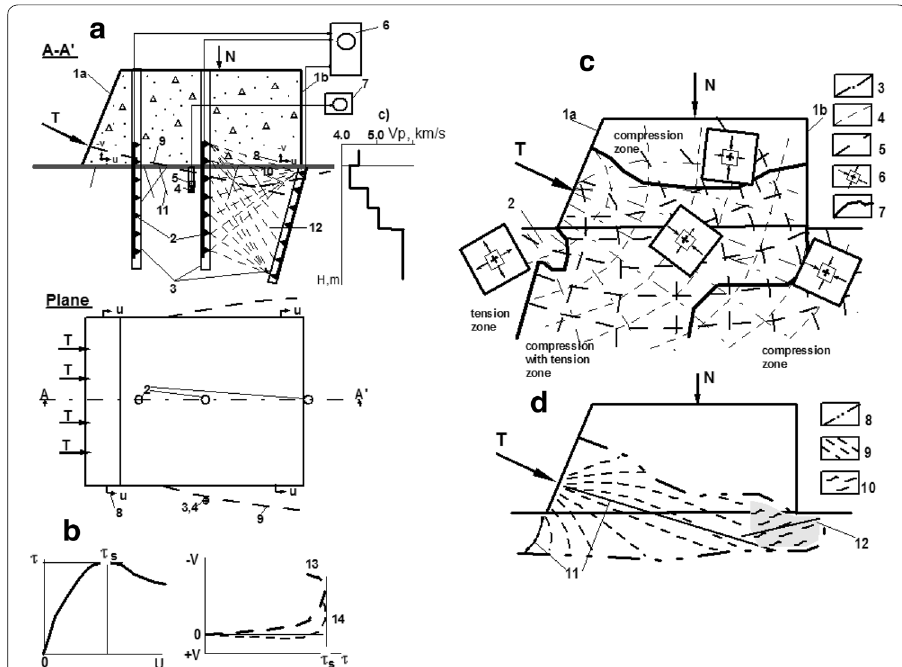
Fig. 8 a Seismic-acoustic measurement layouts in section and in plane; b displacement graphs under front (loaded) plane of the concrete stamp and back planes ( 1b ); c typical velocity Vp graph in rock foundation; d Stress field; and e plastic deformation area at the section of the ‘stamp-rock’ system at the load level of 0.85 from strength. In a – c 1a and 1b —front and back plains of stamp, 2 ultrasonic zonde, 3 drill holes, 4 AE sensor, 5 preamplifier, 6 US scope, 7 magnetic tape, 8 displacement meter, 9 tensile macrofracture, 10 shear macrofracture, 11 natural joints, 12 tomography rays, 13 , 14 vertical displacement vs loading level graphs of the front and back planes, accordingly; In ( e ) and ( d ) 1a , 1 b the same as in a, 2 rock foundation, 3 – 5 traces of the main stresses σ 1 , σ 3 and τ max , accordingly. 6 stress state mode, 7 boundary of the different stress state mode zones, 8 plastic zone boundary, 9 , 10 rupture and shear microfractures, accordingly, 11 , 12 tensile